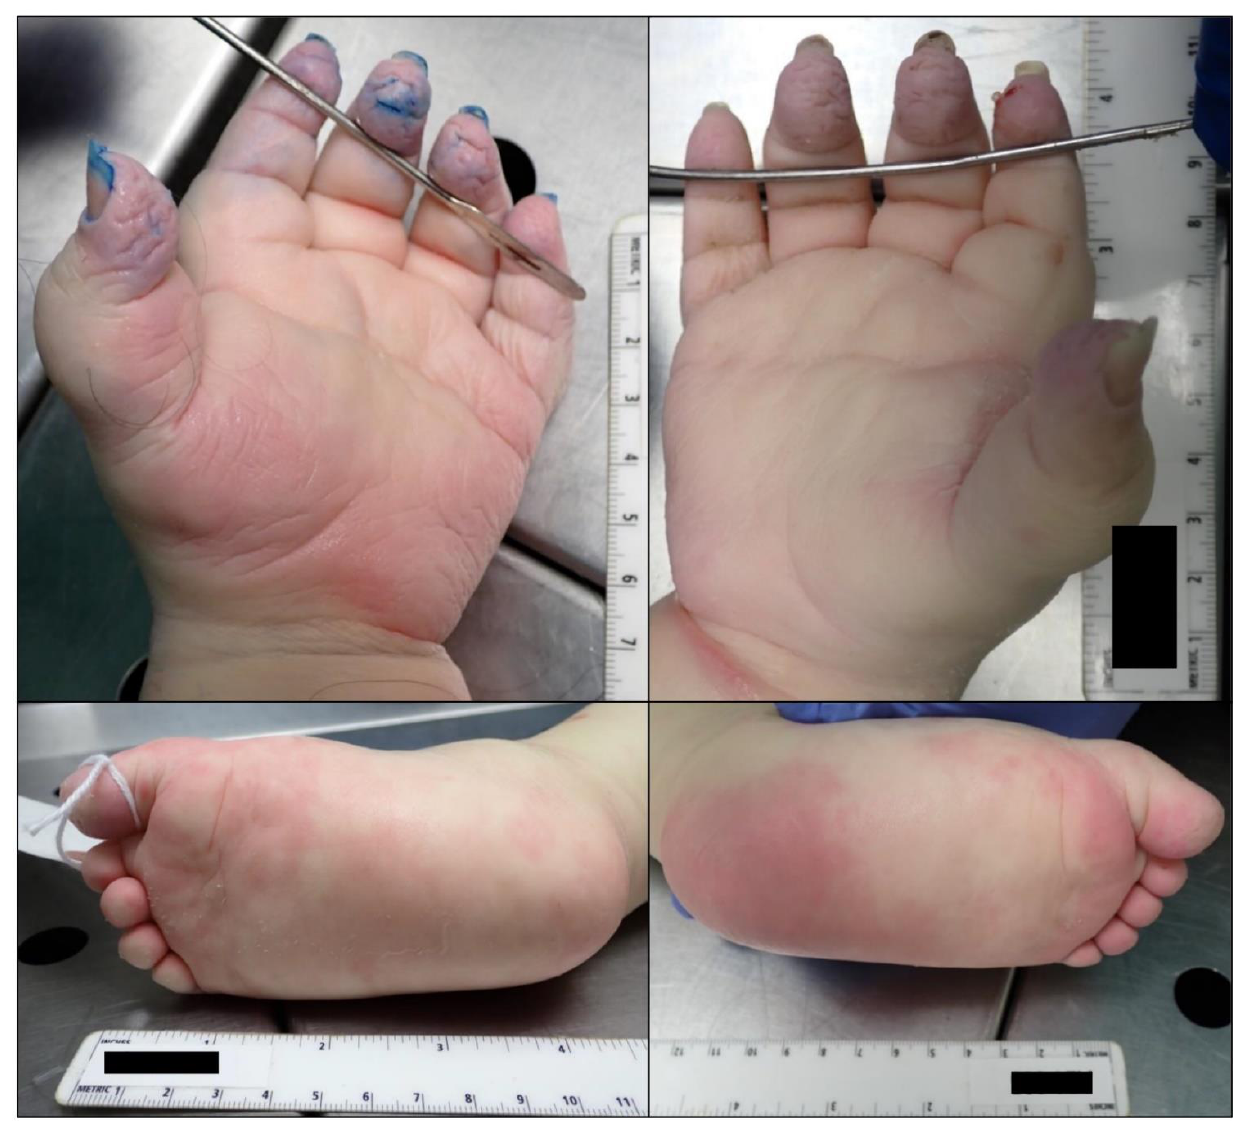
Figure 2. Images of the hands and feet showing ten fingers and ten toes with single transverse palmar creases bilaterally and no plantar creases.